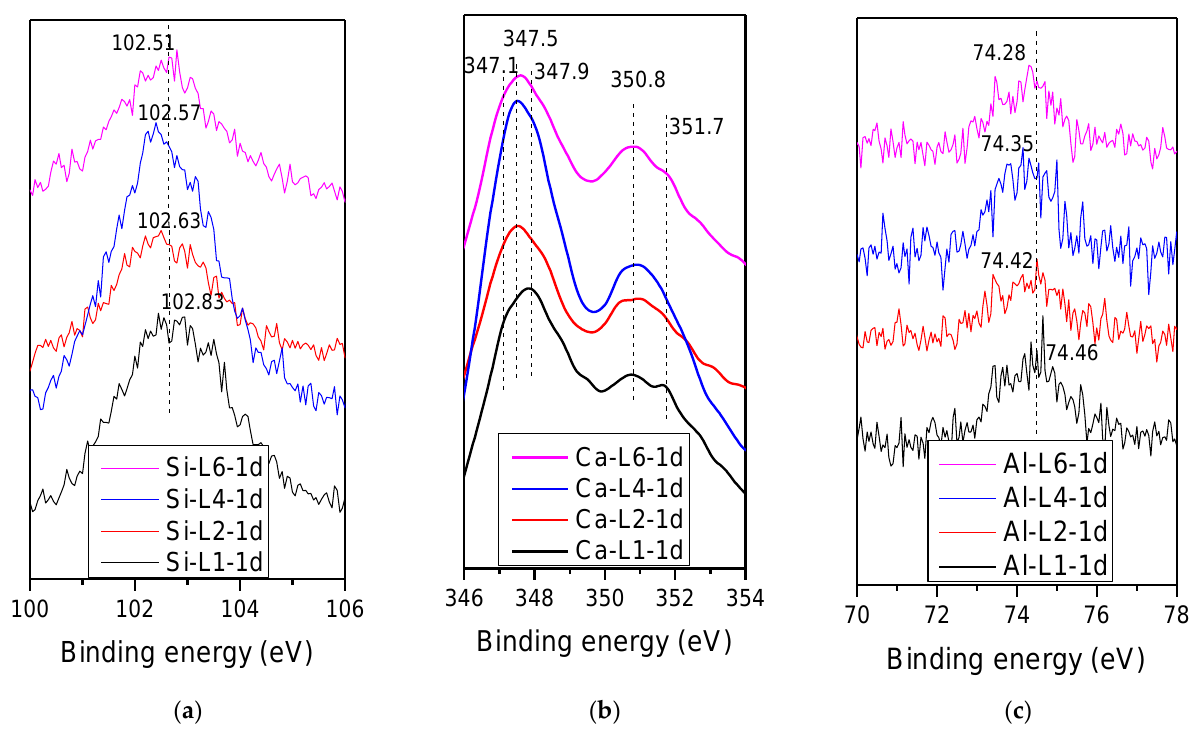
Figure 15. XPS analyses of samples with different w/s values at the age of 1 day: ( a ) Si 2p; ( b ) Ca 2p; ( c ) Al 2p.